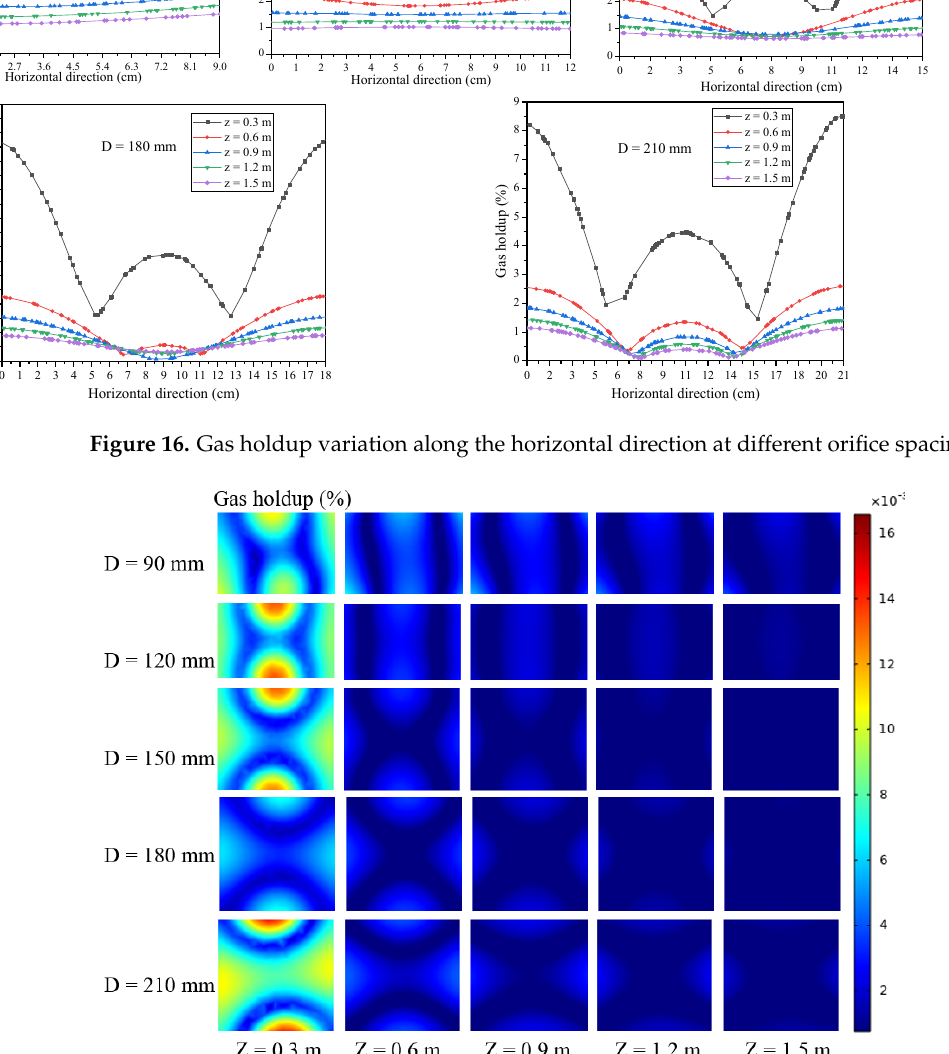
Figure 18. Heat transfer coefficient and power consumption changes at different orifice spacings. 4. Conclusions During the external ice melting process, the ice storage AC system had an excellent heat-transfer performance that could provide a low water temperature. It has wide appli- cation prospects due to the fact of its high efficiency of cold capacity utilization. However,